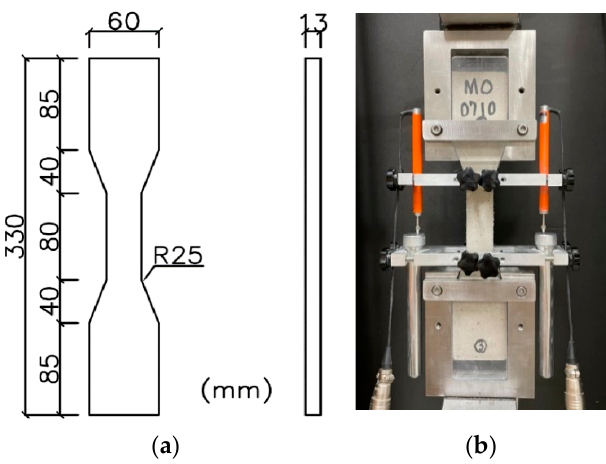
Figure 1. ( a ) Specimen geometry and ( b ) tension test setup.